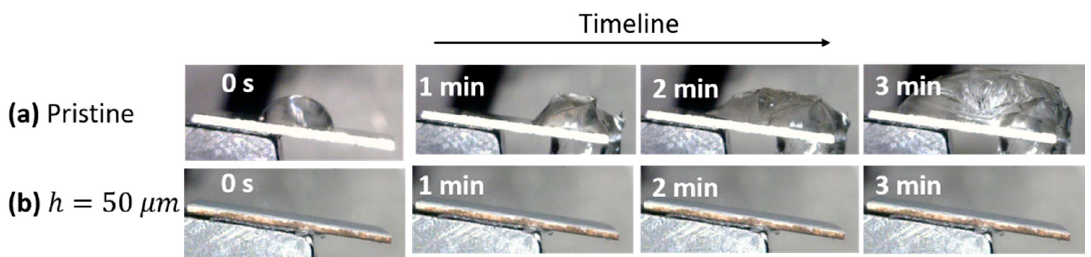
Figure 9. Snapshots of water accumulation ( a ) on the pristine surface compared with ( b ) the laser-treated Al2024 one at − 20 °C. (Reproduced from [111] under the Creative Commons Attribution License).